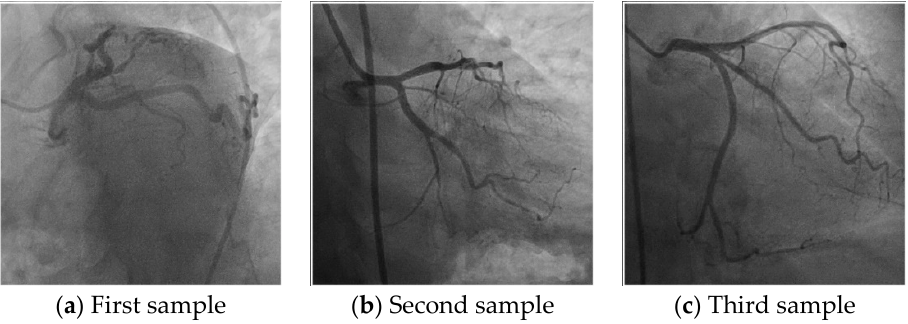
Figure 1. Samples image of the collected coronary angiography image database or human